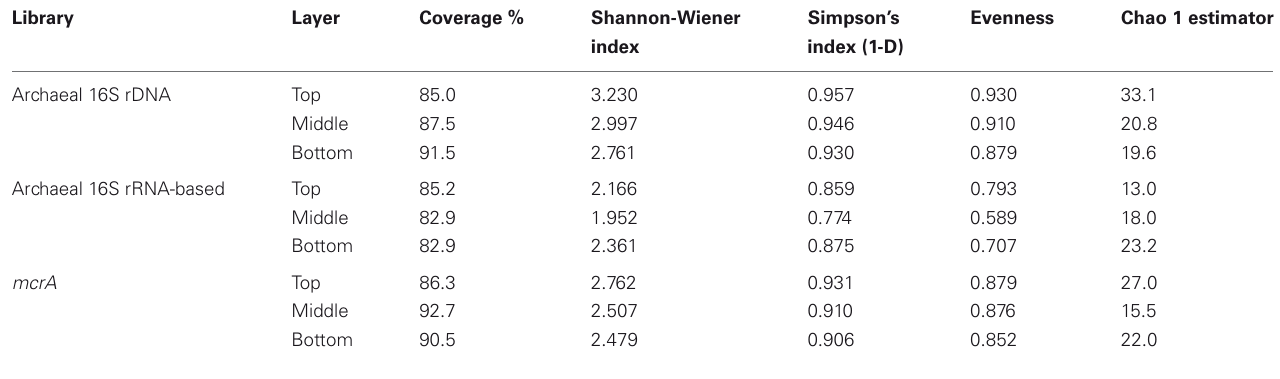
Table 1 | Coverage, diversity, and richness evaluation of constructed